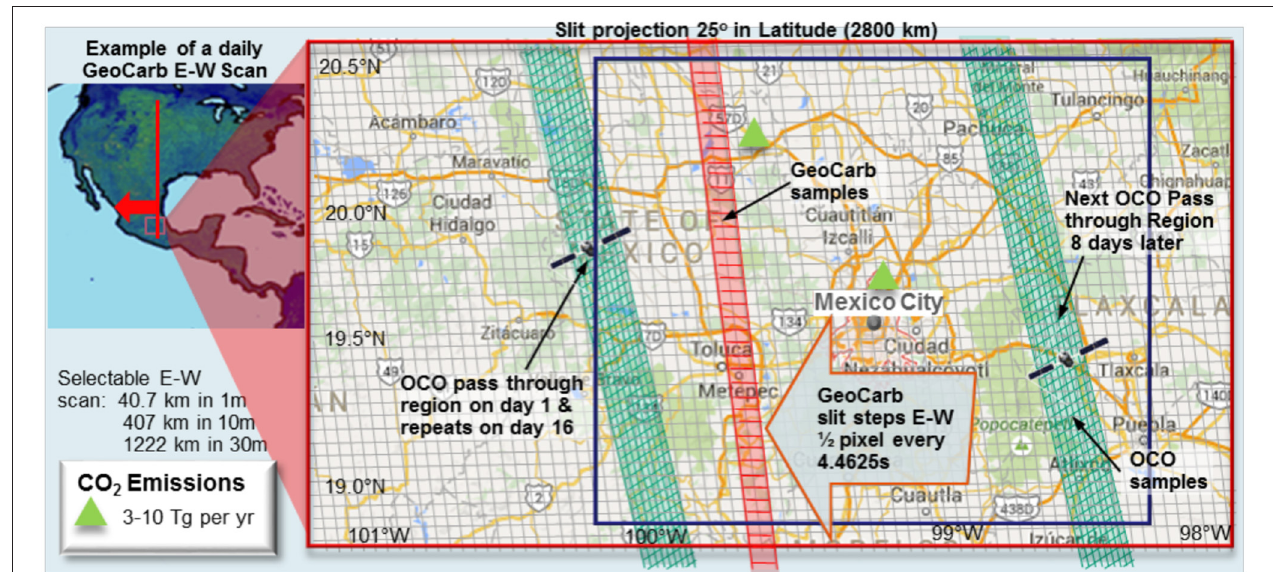
FIGURE 1 | Sample field of view for the area surrounding Mexico City. The green parallelograms represent individual OCO-2 soundings, and each track is traversed in a few minutes, but with a 16 day latency between revisits. By comparison, the red rectangles represent individual GeoCarb soundings, and the shaded region depicts a single observing slit projection. Every 4.4625s, the shaded red area will shift a half width to the left, allowing the area to be scanned in full in a few minutes. The map of North America in the upper left shows the full N/S extent of the slit projection. The green triangles represent power plants that produce 3–10 TgC per year in emissions. GeoCarb would make it possible to verify the reported emissions rates with top down emissions